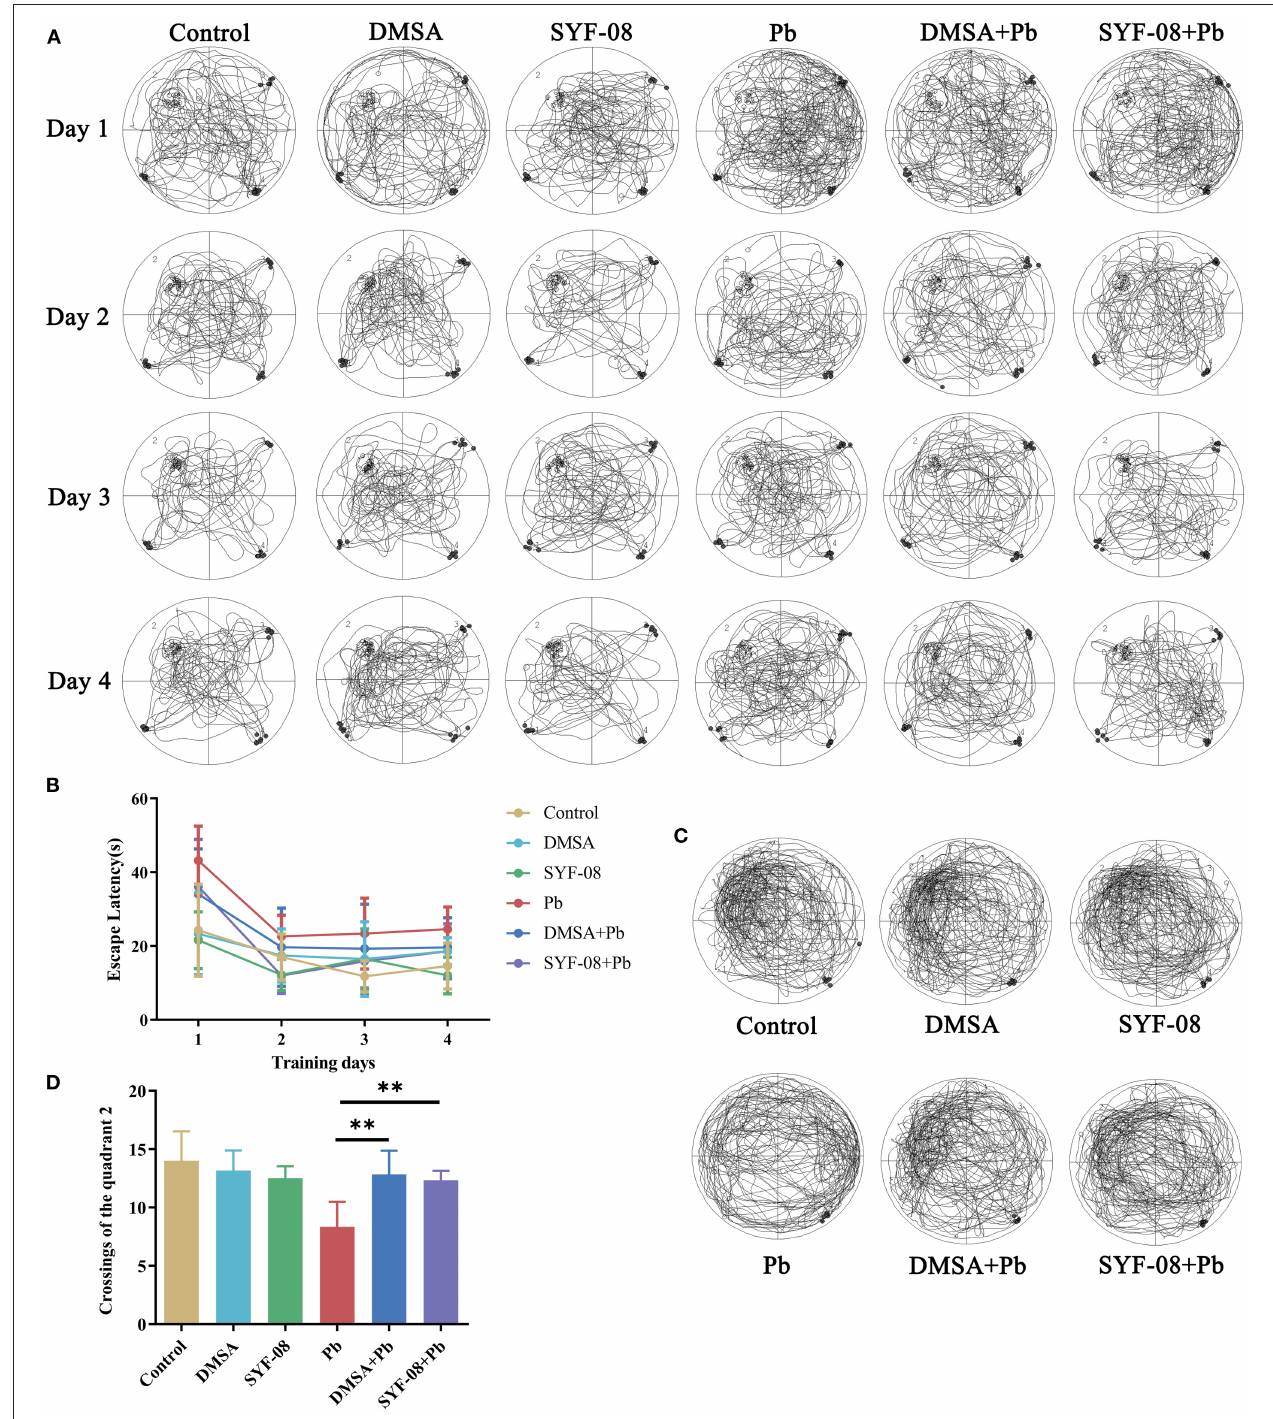
FIGURE 2 | Lactobacillus casei SYF-08 protects against Pb-induced cognitive dysfunction. (A) Representative crossings of the test during the hidden platform trial. (B) The escape latency in the different groups from days 1 to 4. (C) Representative crossings of the test during the probe trial. (D) The number of crossings of the quadrant 2 in the different group. ** P <